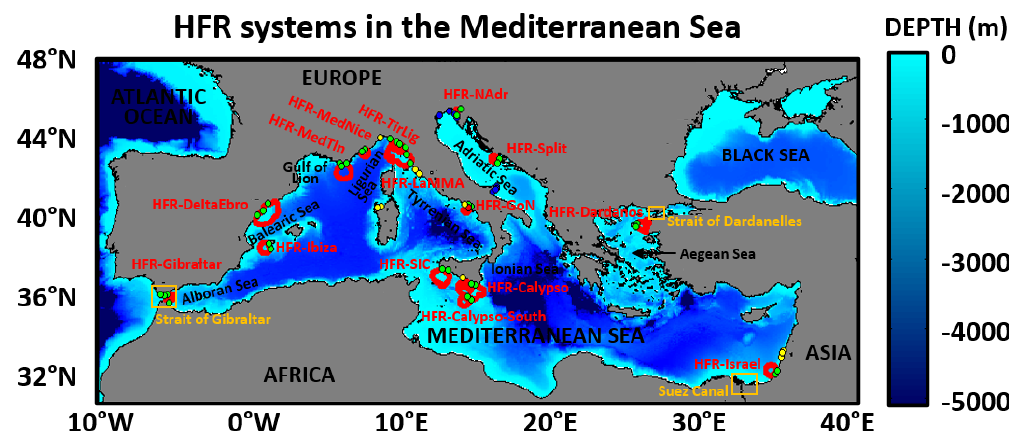
Figure 1. Bathymetric map of the Mediterranean Sea, depicting some local seas and geographical features. The location and spatial coverage of ongoing high-frequency radar (HFR) systems deployed in the basin are represented with red contours. Ongoing, old, and future HFR sites are represented with green, blue, and yellow dots,